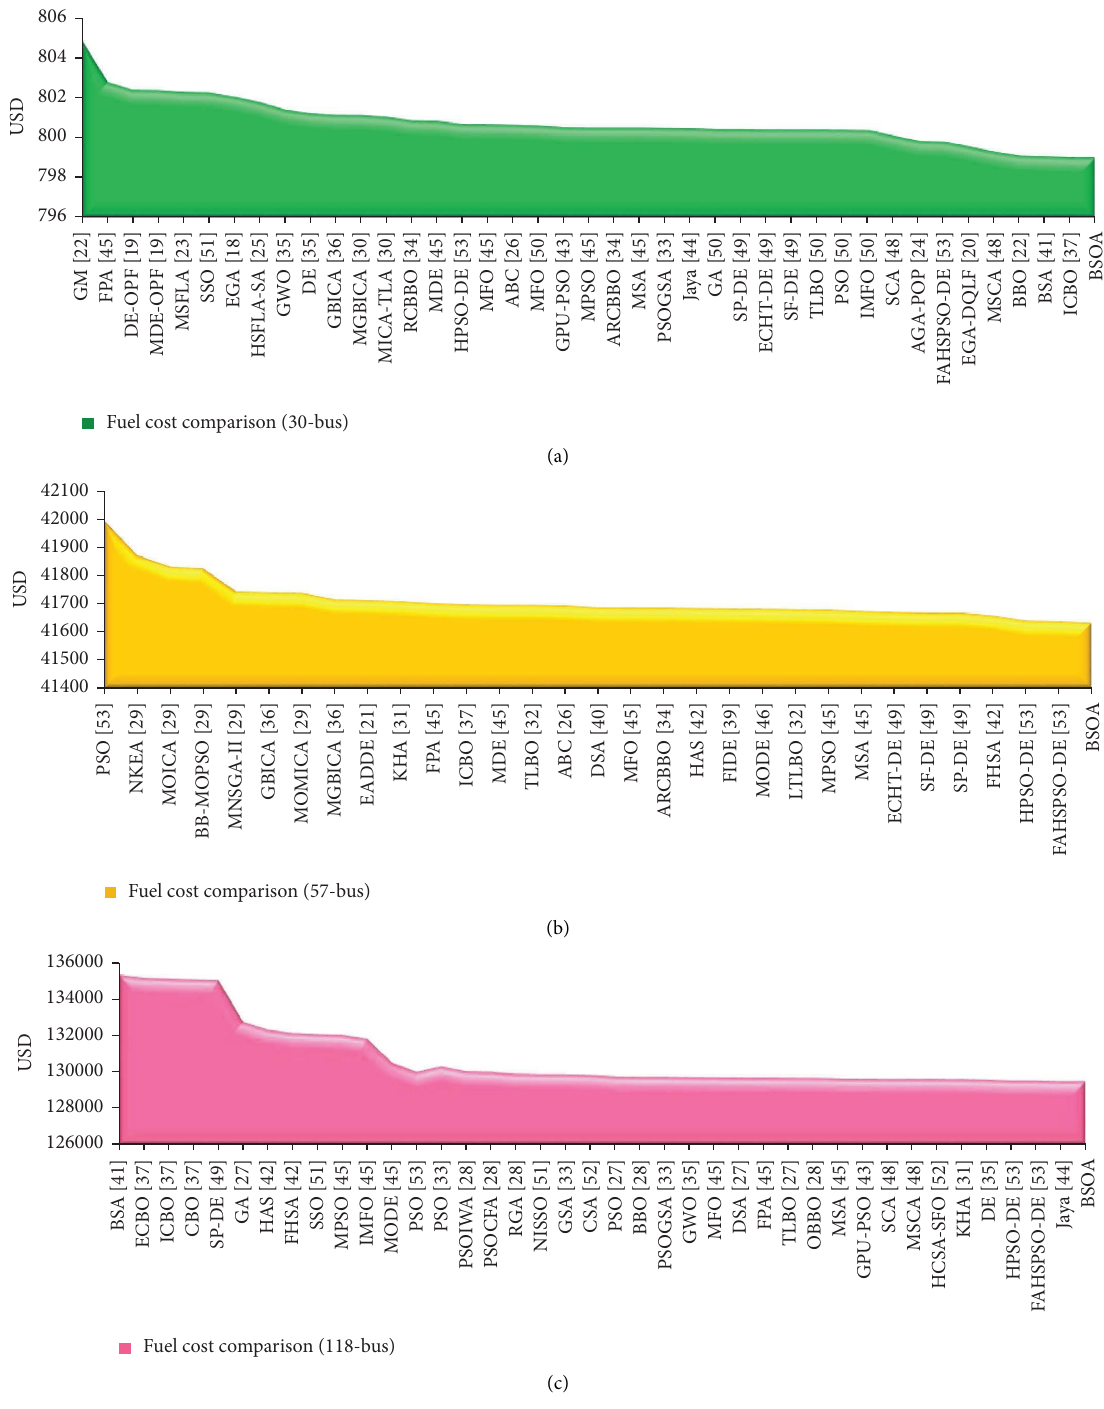
Figure 17: Fuel cost comparison between other foremost optimization techniques reported in the literature: (a) 30-bus; (b) 57-bus; (c) 118-